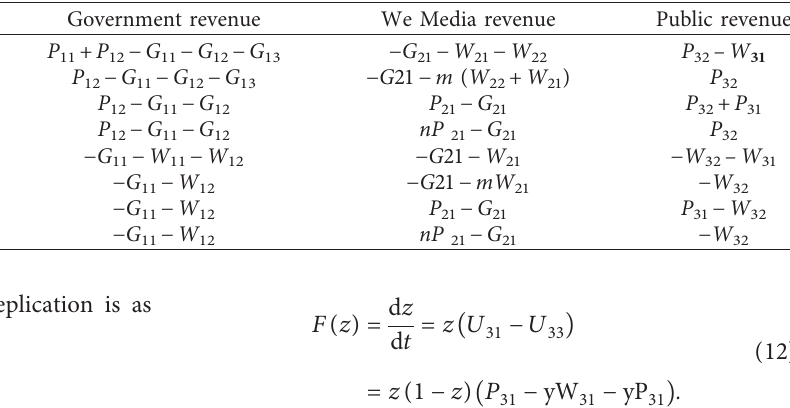
Table 2: “Government-We Media-public” tripartite game payoff